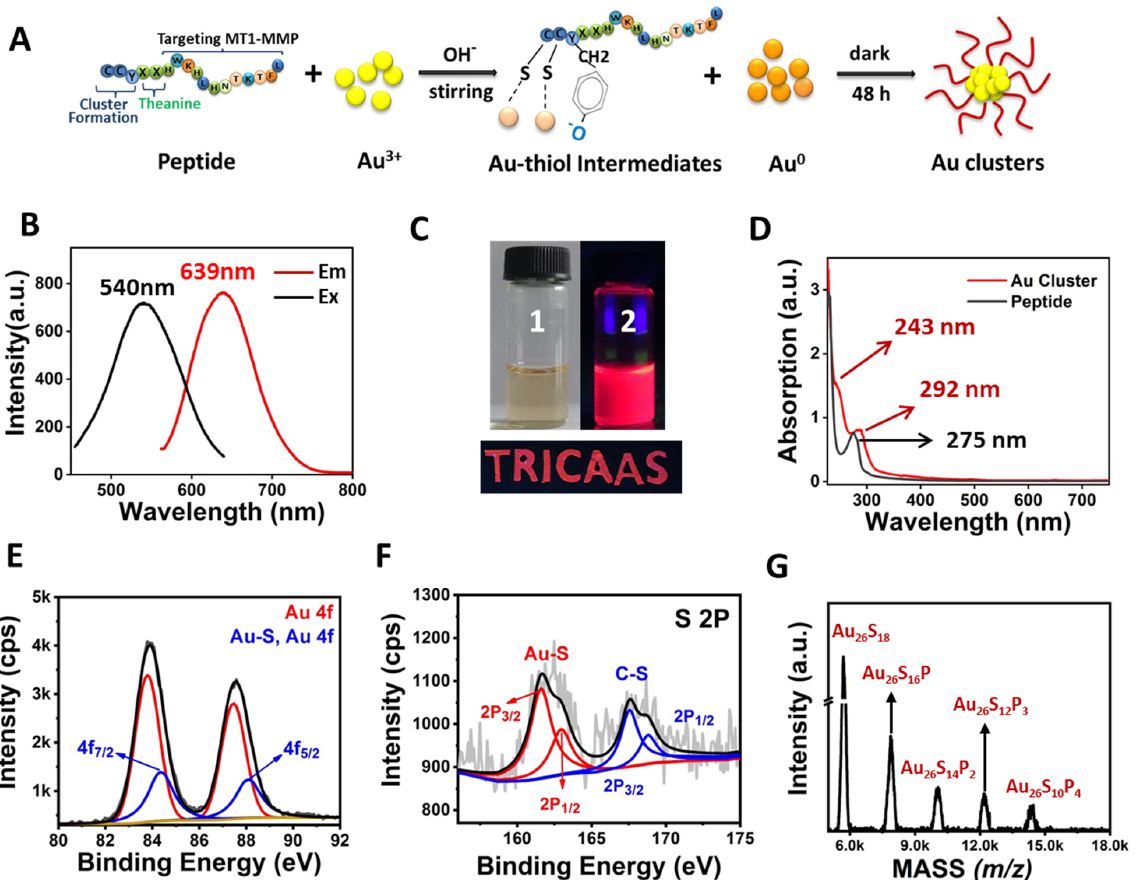
Figure 1. Characterization of Au 26 cluster. ( A ) The formation of Au clusters. ( B ) Fluorescence excitation and emission spectra of Au clusters. ( C ) Photo images of Au clusters under visible (1) and a portable UV lamp (2). The excellent fluorescence properties of Au clusters can make them be used as fluorescent inks. e.g., “TRICAAS” was written using Au clusters emitting red fluorescence under a portable UV lamp. “TRICAAS” is the abbreviation of our affiliation institution. ( D ) Absorption spectra of peptide and Au clusters. ( E , F ) XPS spectrum of Au 4f and S 2P of Au clusters. ( G ) MALDI-TOF-MS spectrum of Au clusters. The mass of the Au 26 P 9 molecule fragment could be written by Au 26 P x S 18–2x , where x ranges from 0 to 9, P represents the peptide, and S represents sulfur.